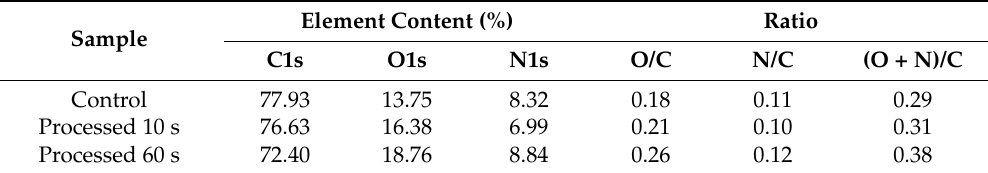
Figure 6. Synthesis curve of C1s-spectrums of the control and glow-like plasma processed samples. ( a ) Control; ( b ) Treated for 10 s; ( c ) Treated for 60 s. Table 1. Relative element contents and atomic ratios.